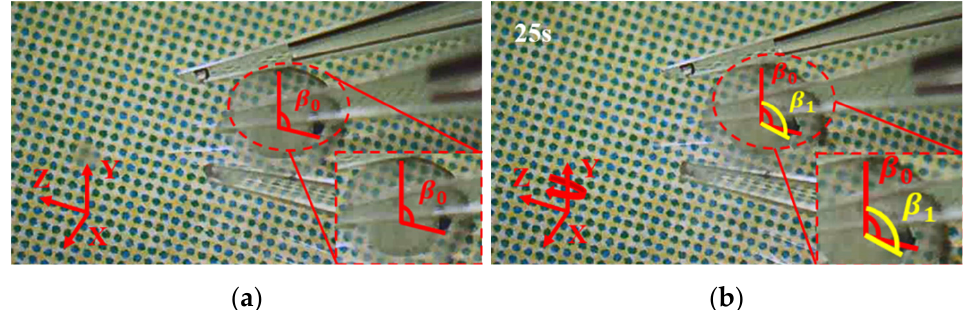
Figure 22. The zebrafish embryo is rotated about axis Y. ( a ) the zebrafish embryo is moved to a distance; ( b ) the zebrafish embryo is rotated about axis Y.